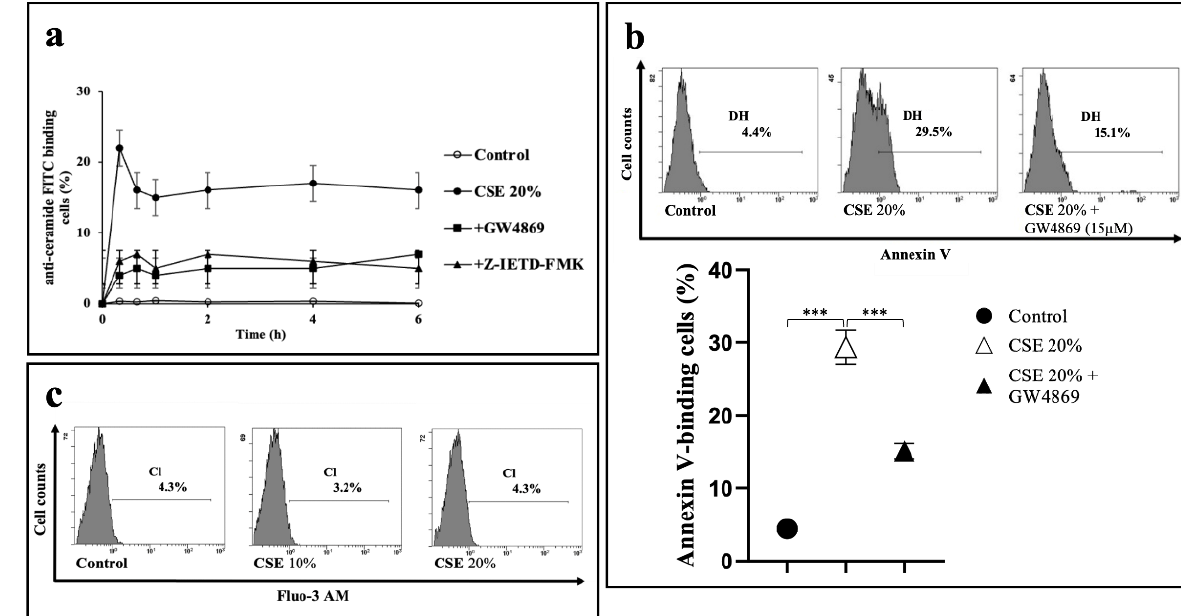
Figure 4. CSE-induced eryptosis requires caspase-8-mediated ceramide formation and is Ca 2+ inde- pendent. ( a ) Time-course of ceramide formation in 20% CSE-treated RBCs pre-incubated for 1 h in the absence or in the presence of nSMase inhibitor GW4869 (15 μM) or caspase -8 inhibitor Z-IETD- FMK (25 μM). ( b ) Percentage of PS-exposing RBCs after 1 h pre-treatment in the absence or in the presence of GW4869 (15 μM) followed by 24 h treatment with CSE. Values are means ± SD of six independent experiments carried out in triplicate. *** p < 0.001 (ANOVA associated with Tukey’s test). ( c ) Analysis of intracellular calcium levels. Representative of four experiments carried out in triplicate with comparable results. RBCs incubated with vehicle were used as control.